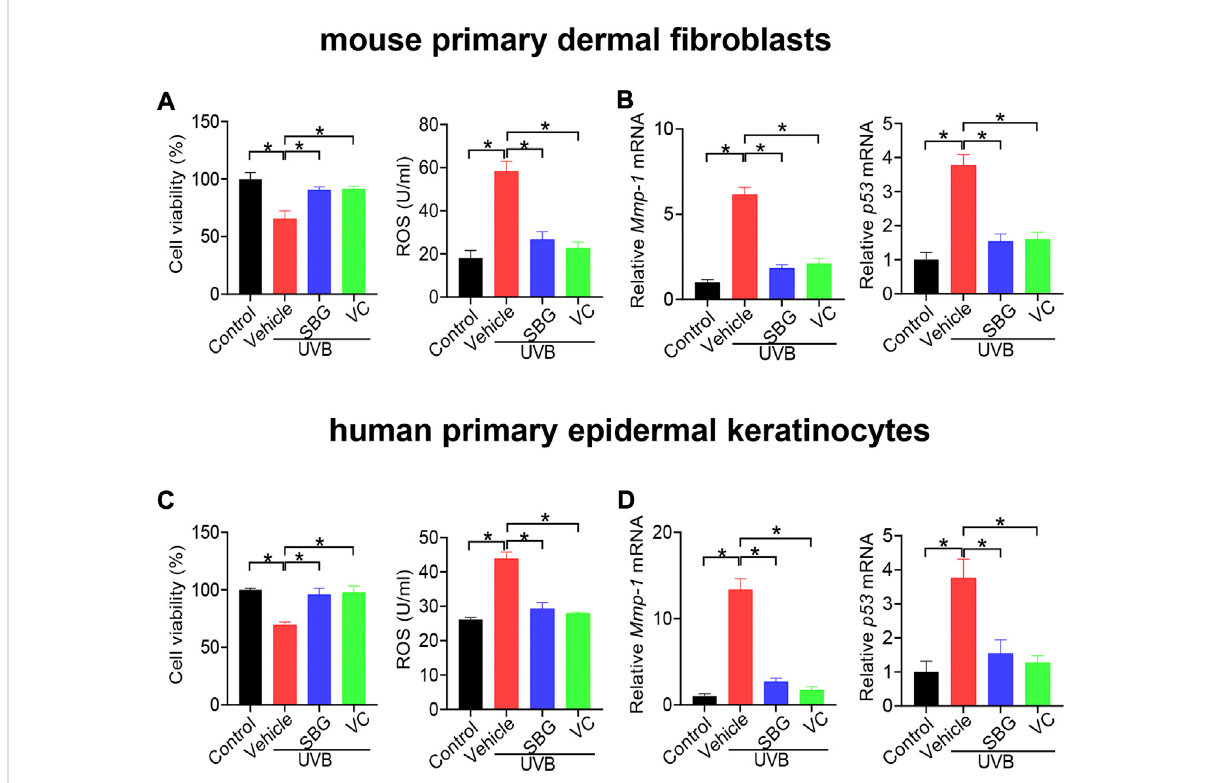
FIGURE 6 SBG attenuates UVB-induced senescence in mouse primary dermal fi broblasts and HEKa cells . (A) Effects of SBG on cell viability and ROS accumulation for UVB-treated mouse primary dermal fi broblasts. (B) Effects of SBG on mRNA expression of Mmp-1 and p53 in UVB-treated mouse primary dermal fi broblasts. (C) Effects of SBG on cell viability and ROS accumulation for UVB-treated HEKa cells. (D) Effects of SBG on mRNA expressionof Mmp-1 and p53 inUVB-treatedHEKacells.Dataaremean±SD( n =3).* p <